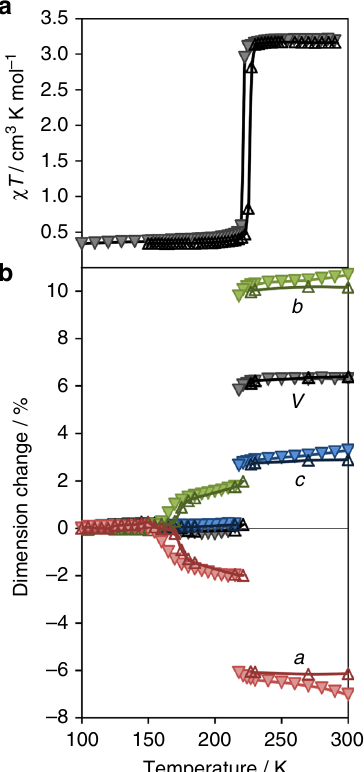
Fig. 2 Variable temperature behaviour of [Fe]. a Molar magnetic susceptibility product χ M T vs . temperature. b the percentage change in lattice dimension for a, b, c and volume. Data are presented upon ( fi lled triangle ) cooling and ( un fi lled triangle ) warming between the adjacent metal cyanide grids of 3.0843(5) Å. Modelling of the electron density in the pore space revealed 2 ethanol molecules per formula unit.